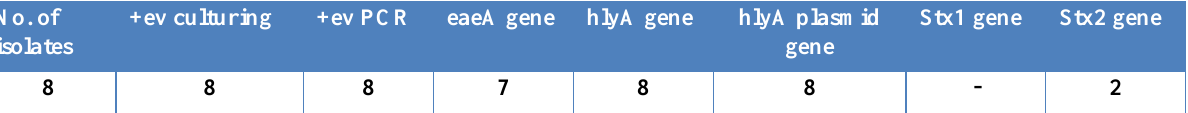
Table, 1: Showed results of PCR assay to confirm diagnosis of E.coli O157:H7